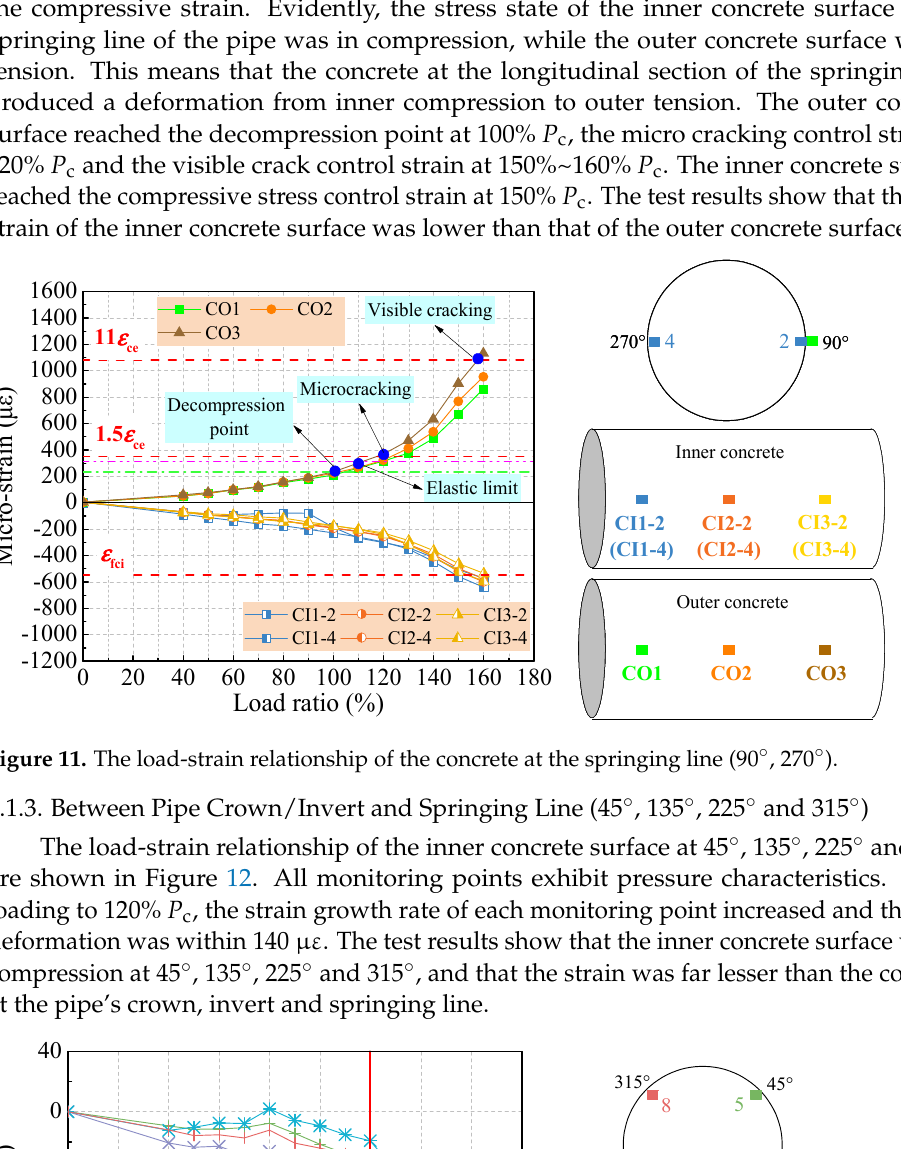
Figure 10. The load-strain relationships of the concrete at: ( a ) Crown (0°); ( b ) Invert (180°).